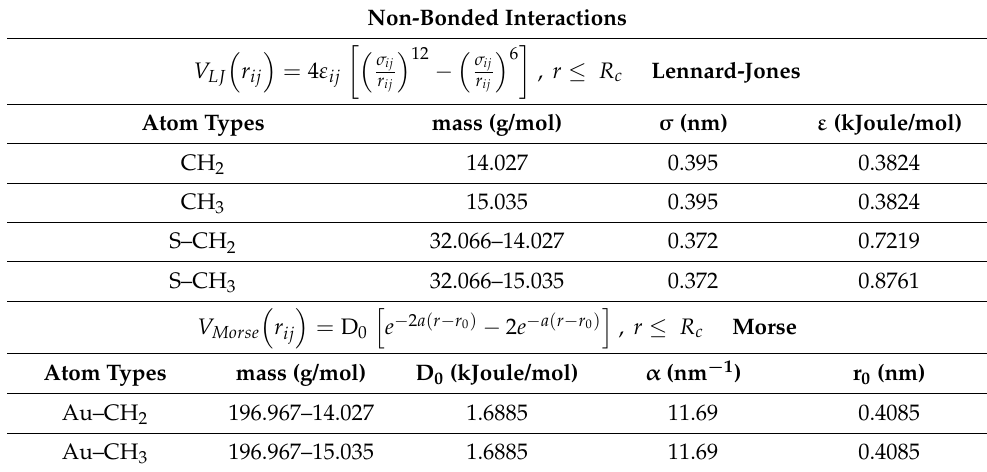
Figure A1. Snapshot from MD simulation of hybrid polyethylene/grafted gold nanoparticle at 450 K. Au nanoparticle (2461 atoms, diameter of 5.04 nm) is shown. In yellow is the Au and in grey are the terminal CH 3 groups. In red are the grafted CH 2 and the grafted CH 3 monomers. The initial configuration of the grafted NP with the short anchored polymeric chains and with the long anchored polymeric chains. Table A1. Non-bonded interactions of the atomistic force field for the model PE/Au nanocomposites.